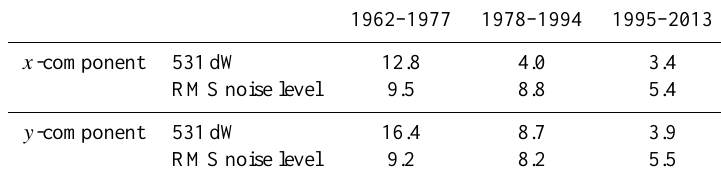
Table 2. The vector differences of the amplitudes of IMF 5 and IMF6 for the three sub-series (frequency